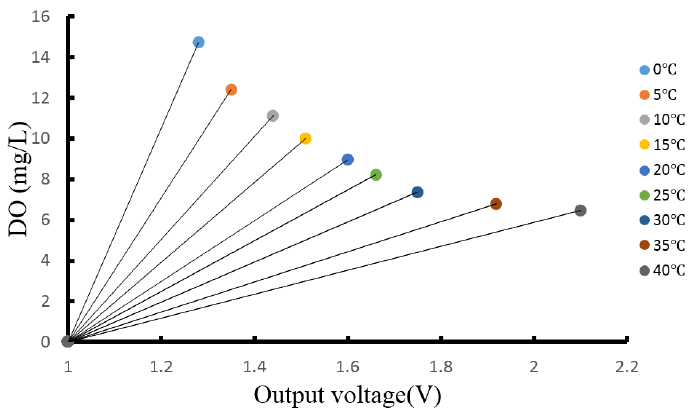
Figure 5. Line chart of the DO content and output voltage signal.